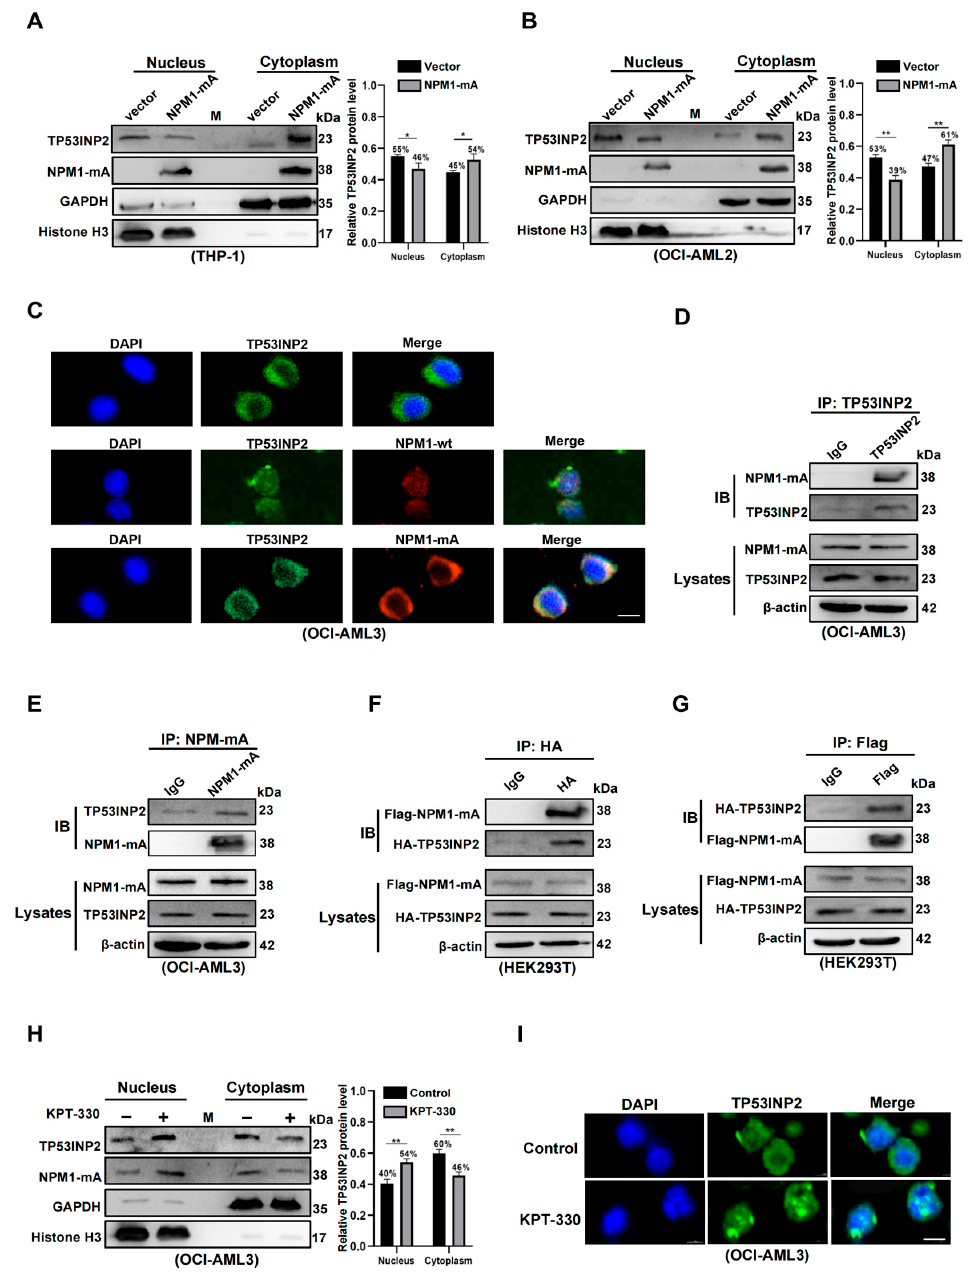
Figure 4. NPM1-mA interacts with TP53INP2 and leads to the cytoplasmic delocalization of TP53INP2. ( A , B ) Western blot analysis of cytoplasmic and nuclear TP53INP2, cytoplasmic and nuclear NPM1-mA protein levels in NPM1-mA-enforced OCI-AML2 and THP-1 cells. The bar graph exhibited the relative protein levels. ( C ) Immunofluorescence analysis ( × 600) of TP53INP2, NPM1-mA, and NPM1-wt localization in OCI-AML3 cells. Scale bar: 25 μ m. ( D , E ) Total protein extracts from OCI-AML3 cells were immunoprecipitated with anti-NPM1-mA antibodies or anti-TP53INP2 antibodies, followed by immunoblotting for TP53INP2 and NPM1-mA, respectively. ( F , G ) The HEK293T cells were co-transfected with HA-TP53INP2 and Flag-NPM1-mA plasmids, and then cell lysates were immunoprecipitated with anti-HA antibodies or anti-Flag antibodies, followed by immunoblotting for HA-TP53INP2 and Flag-NPM1-mA. ( H ) Western blot analysis of cytoplasmic and nuclear TP53INP2, cytoplasmic and nuclear NPM1-mA protein levels in OCI-AML3 cells treated